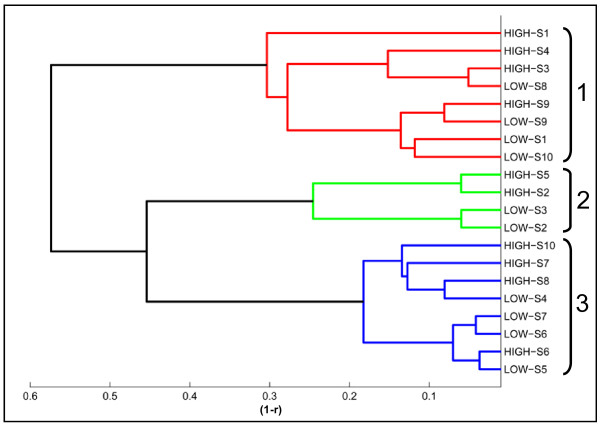
Dendrogram representing the overall clustering over the 24 hour time period. After correction for multiple measurements, 21 of the 104 markers of interest (p < 0.05) were included in the analysis. Three distinct clusters can be appreciated containing subjects from both the high and low HDL groups. The axis indicates one minus the correlation coefficient (1-r).